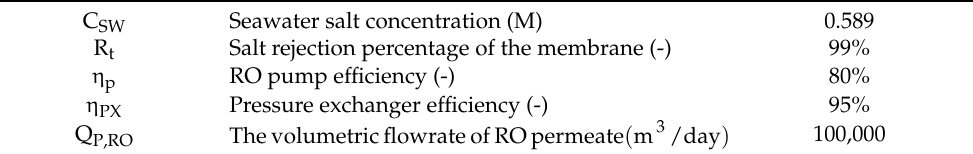
Table 1. The parameters used in stand-alone RO and/or RO-ERD process